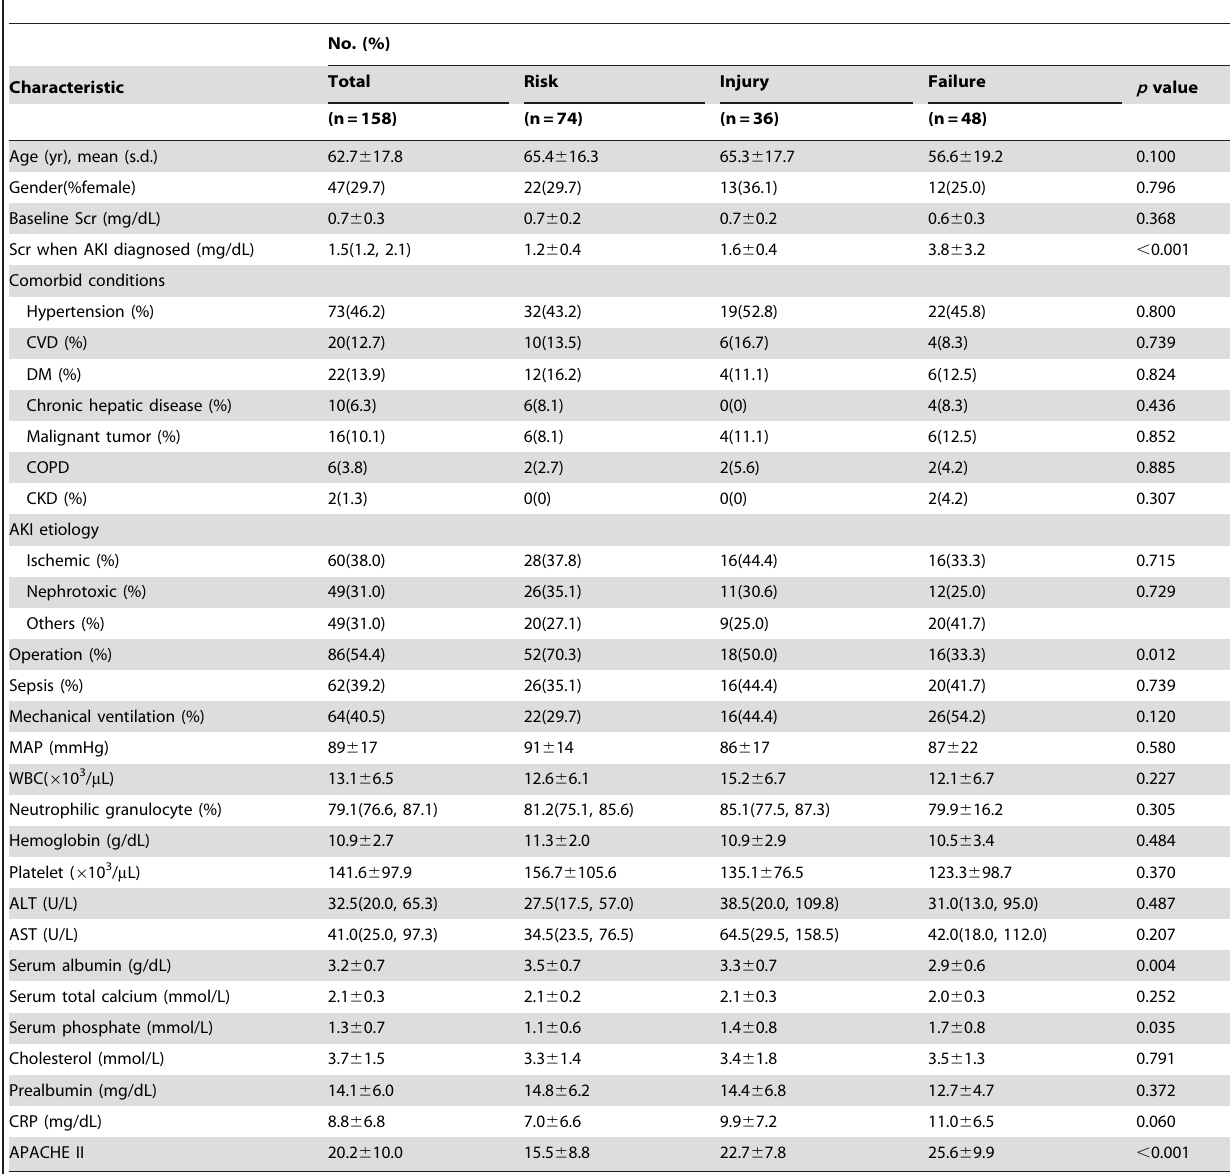
Table 1. Baseline demographic and clinical data of patients at the time of acute kidney injury diagnosis stratified by RIFLE